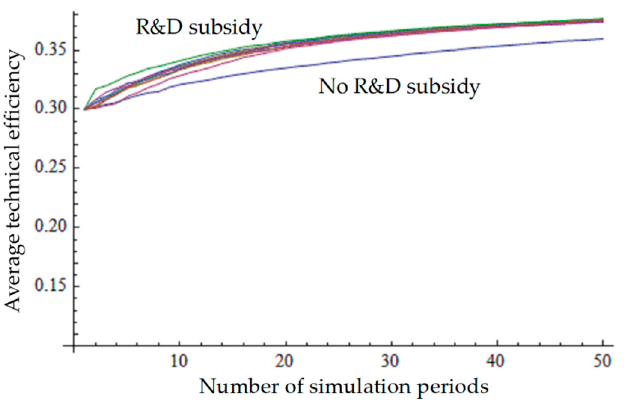
Figure 12. Impact of the R&D subsidy for traditional technology firms on average technical efficiency.